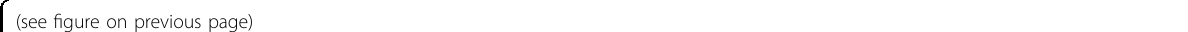
Fig. 5 Therapeutic inhibition of mTOR decreases the fraction of cancer stem-like cells in vivo. a Graph and fl ow plots depicting the percentage of ALDH high CD44 high cells identi fi ed by fl ow cytometry in UM-HMC-3B xenograft tumors retrieved from mice treated with temsirolimus or vehicle control for 7 days. Once tumors ( n = 6 per experimental condition) reached an average volume of 200 mm 3 , mice received daily intraperitoneal injections of 10 mg/kg temsirolimus or vehicle control. t -tests were used to verify statistical signi fi cance. b Immuno fl uorescence staining of xenograft tumors after 7-day treatment with 10 mg/kg temsirolimus or vehicle. ALDH1 is stained in green, CD44 is stained in red and DAPI is stained in blue. Scale bars represent 25 µm. c Immunohistochemical analysis for p-S6K1 or Factor VIII in xenograft tumors (UM-HMC-3B) retrieved from mice that received temsirolimus or vehicle. Images were taken at 200×. Scale bars represent 25 µm. d , e Graphs depicting the quanti fi cation of p-S6K1-positive cells ( d ) and Factor VIII-positive blood vessels ( e ), as determined by quanti fi cation of fi ve microscopic fi elds per tumor ( n = 6) by an investigator blinded for experimental conditions. Images were taken at 200×. Scale bars represent 25 µm. f Western blot analyses for mTOR, p-S2448- mTOR, S6K1, p-T421/S424-S6K1, and Bmi-1 expression in the whole tumor lysate of each individual tumor (specimen) after 7-day treatment with either 10 mg/kg temsirolimus or vehicle control ( n = 6). g Graph depicting tumor volume after 7 days of treatment with 10 mg/kg temsirolimus or vehicle. h Graph depicting regression analysis of tumor volume after 7-day treatment with temsirolimus (blue line) or vehicle control (black line). i Graph depicting the average mouse weight during the experimental period. Error bars indicate standard